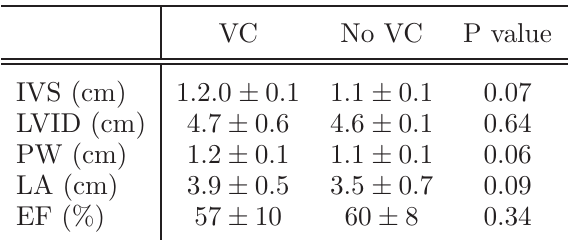
Table 3 Echocardiographic parameters of the patients with and without cardiac valve